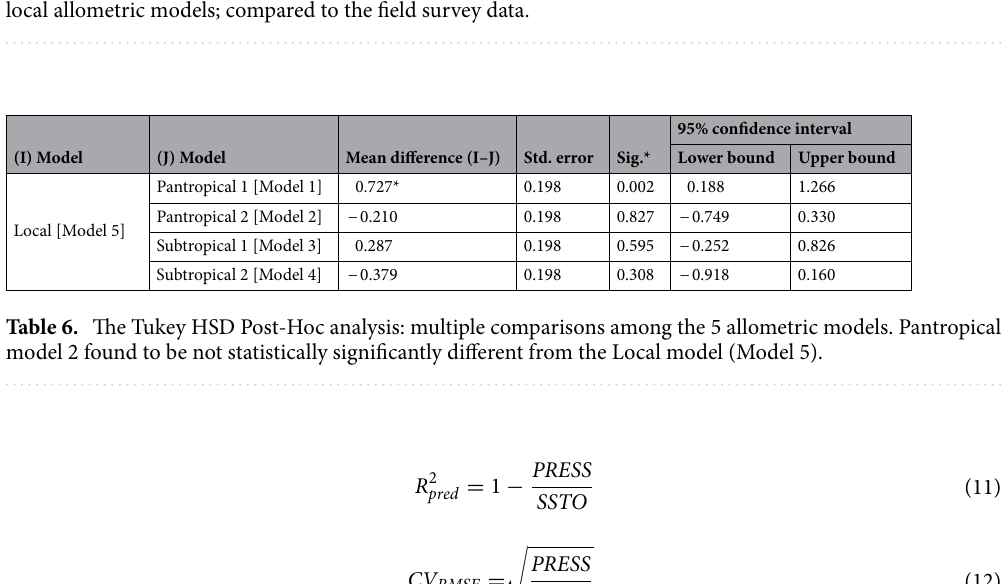
Table 5. The species count, DBH and AGB range within the study area, as assessed by the pantropical and local allometric models; compared to the field survey data.